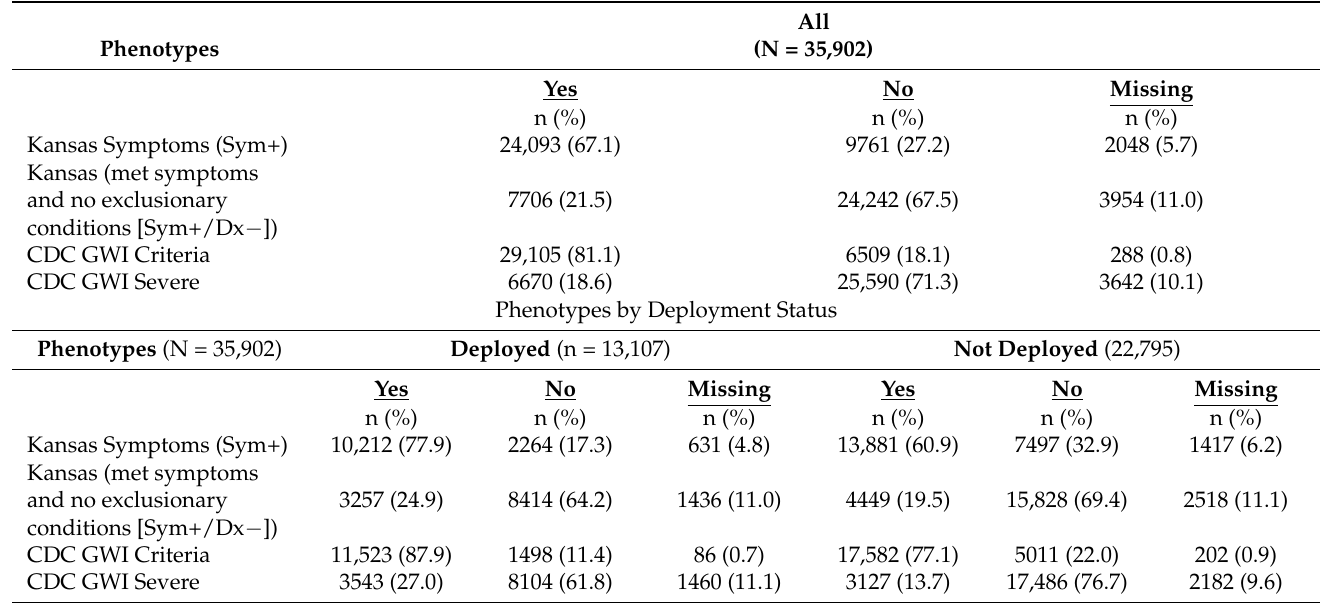
Table A4. VA CSP 2006/MVP 029 Missingness analyses of Phenotypes.